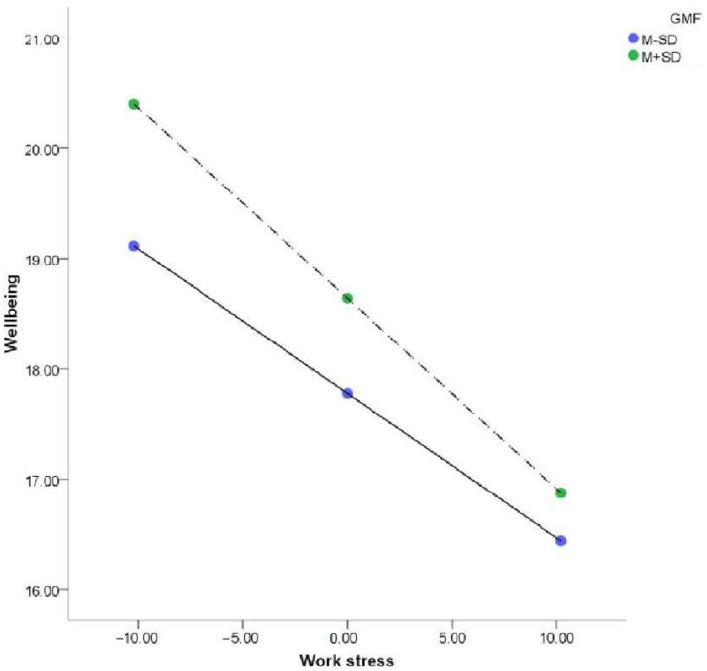
Figure 3. The moderating effect of factor-GMF (grasping the meaning of failure).